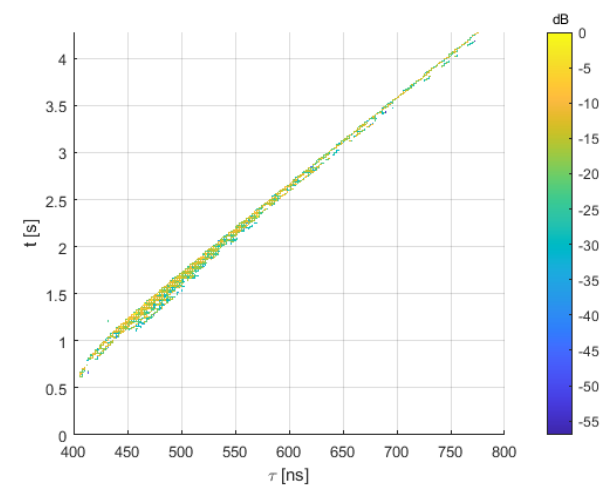
Figure 20. Measured PDPs at the alley at high speeds (120 km/h). By aligning with respect to the main component, the PDPs of Figure 21 were obtained. The fading of the echoes with respect to previous campaigns becomes more clearly visible now. It is important to note the null values during the first 0.75 s. These correspond to the car still located below the bridge and out of the main lobe of the transmitting an- tenna. For the following calculations, these samples have been removed.